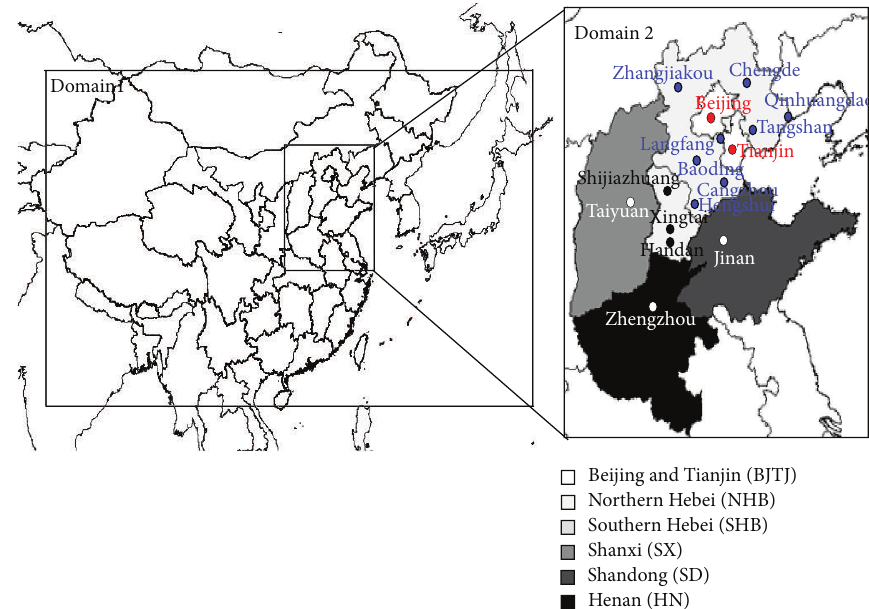
Figure 1: The model domain (Hebei province is divided into the southern Hebei (SHB, which includes Shijiazhuang, Xingtai, and Handan) and northern Hebei (NHB, which includes Zhangjiakou, Chengde, Qinhuangdao, Tangshan, Langfang, Baoding, Cangzhou, and Hengshui).